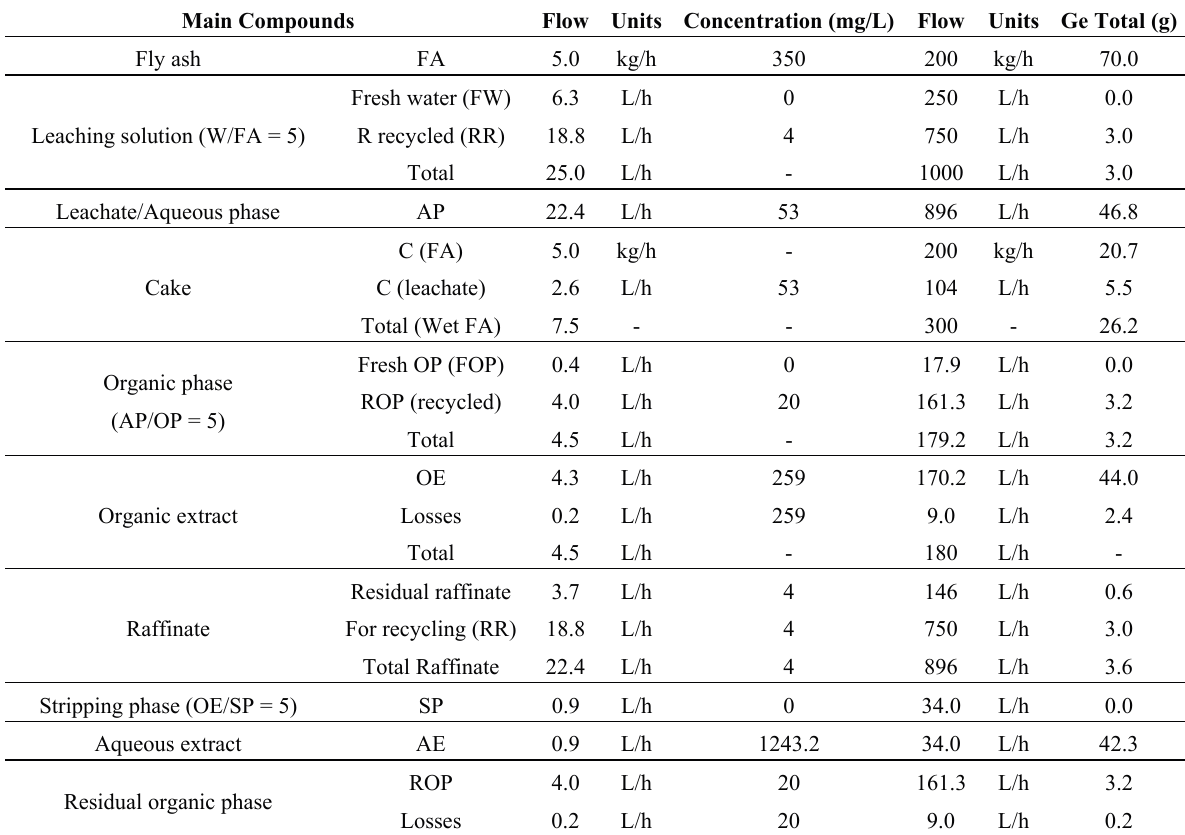
Table 3. Pilot plant and demonstration plant preliminary mass balance. Ge mass